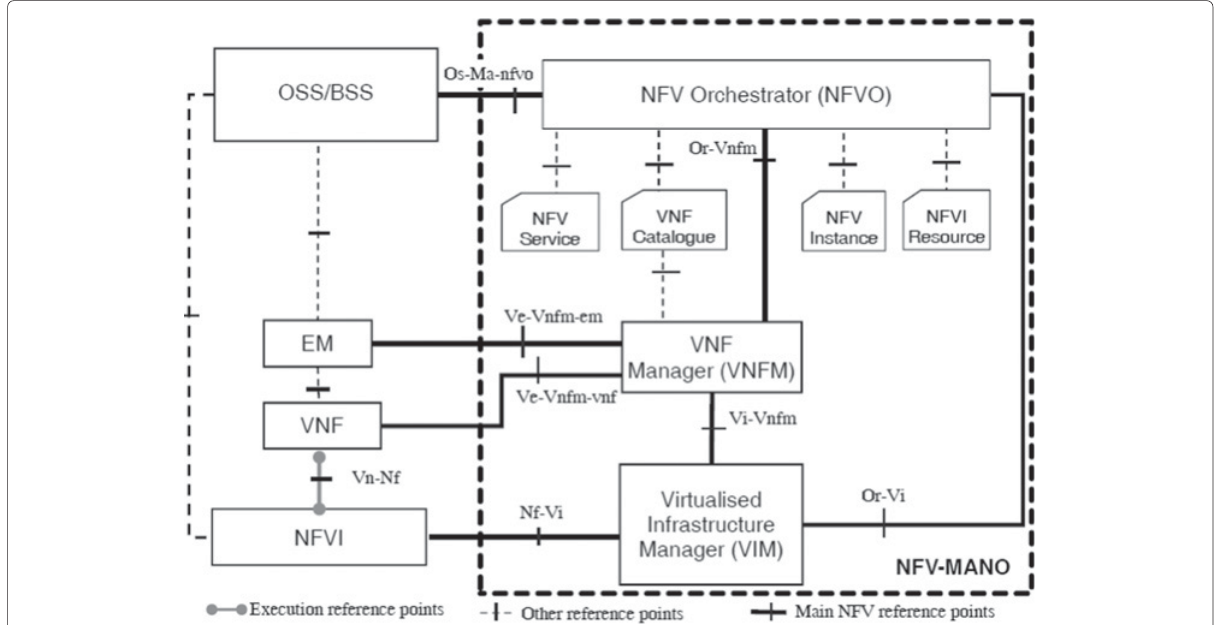
Fig. 4 The NFV-MANO architectural framework with reference points,